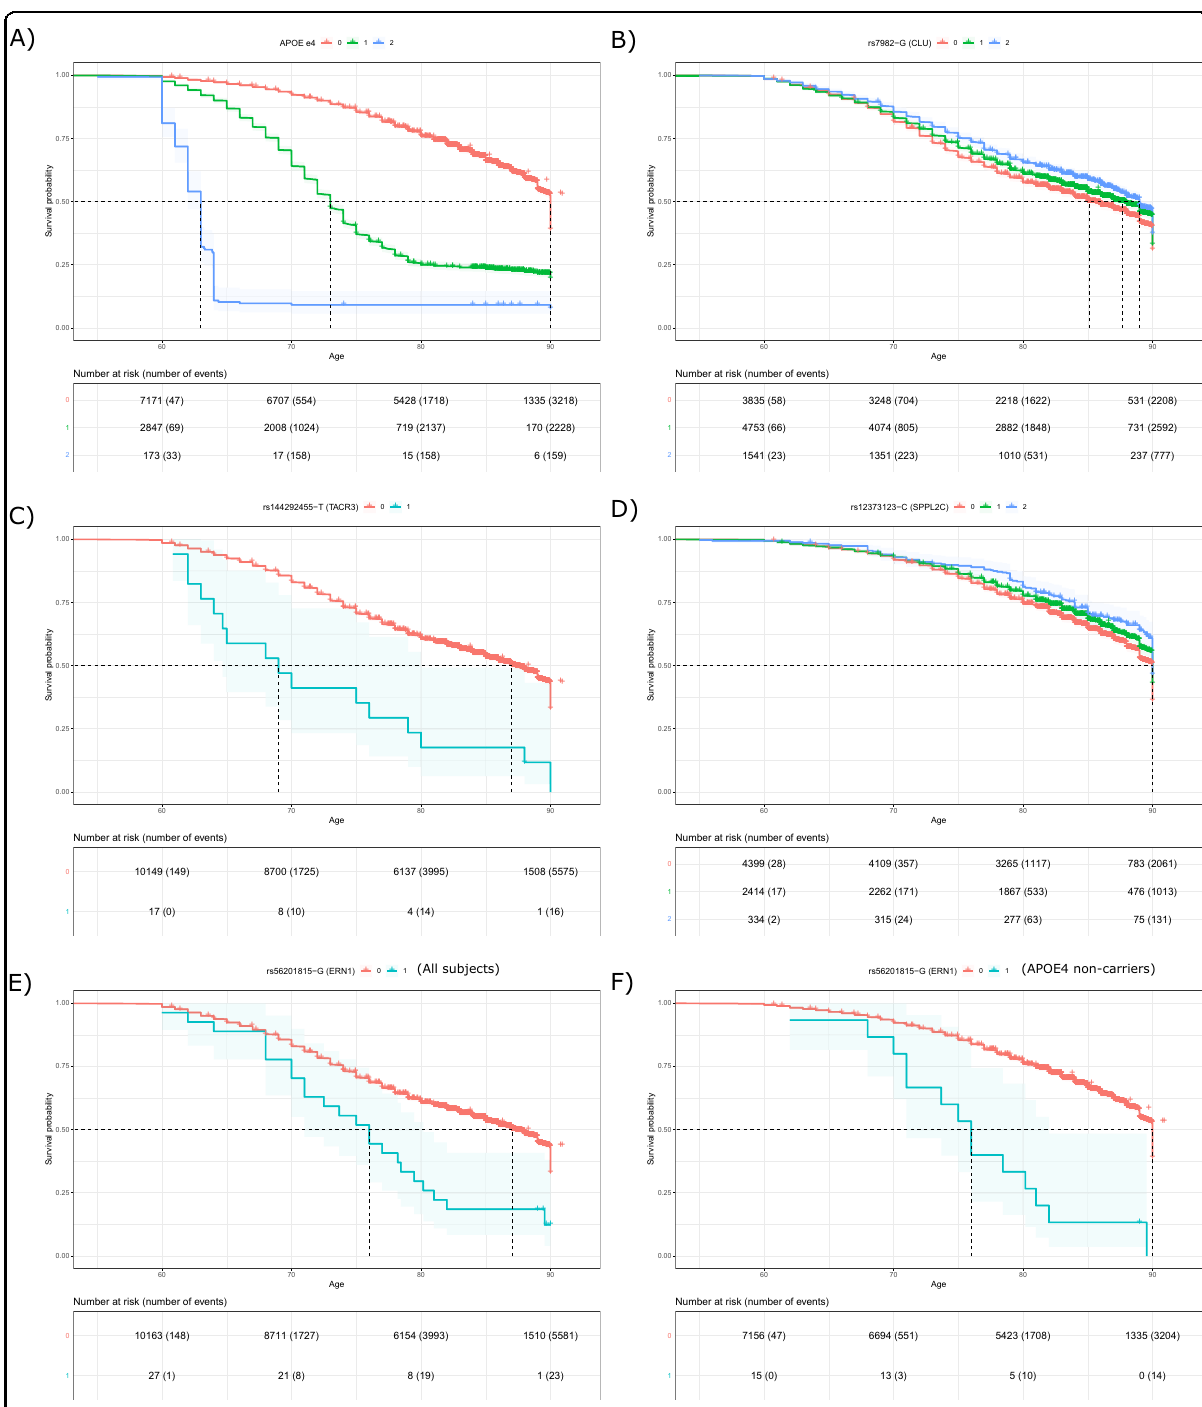
Fig. 2 Probability of remaining free of AD (survival probability) and risk tables in the ADSP sample for genotype groups. A APOE ε 4; B rs7982; C rs144292455; D rs12373123; E rs56201815 in all subjects; F rs56201815 in the APOE ε 4